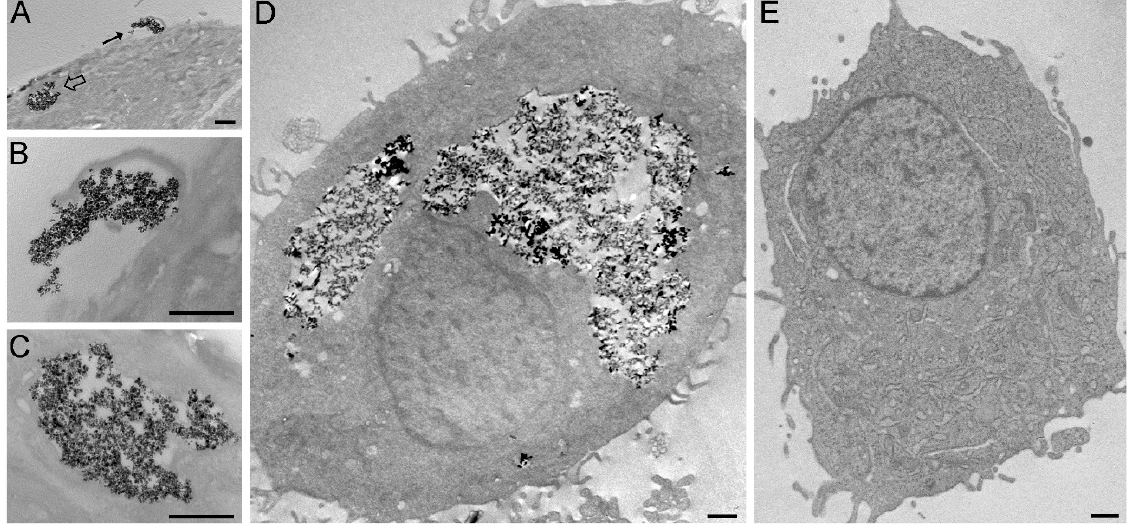
Figure 3. Transmission electron micrographs of cells treated for 24 h with TAT-PLGA-BMNPs ( A – D ) and the untreated (control) cell ( E ). ( A ) Clusters of NPs occur both at the surface (arrow) and inside (open arrow) the cell. ( B ) High magnification of the NPs at the cell surface (arrow in A): Note the cell protrusion indicating a phagocytic process. ( C ) High magnification of nanoparticles enclosed in a cytoplasmic vacuole (open arrow in A ). ( D ) The internalized nanoparticles are stored inside large vacuoles. Bars = 1000 nm ( A , D , E ), 500 nm ( B , C ).